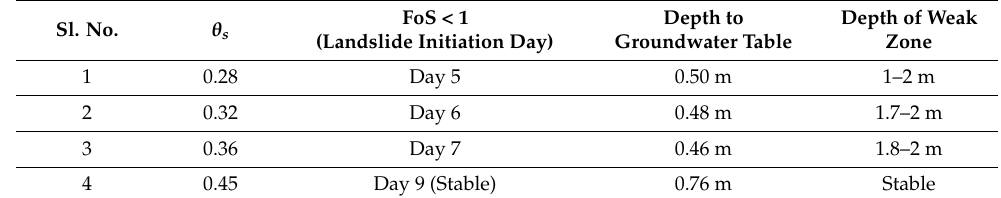
Table 2. Comparative analysis for landslide initiation based on variation in θ s